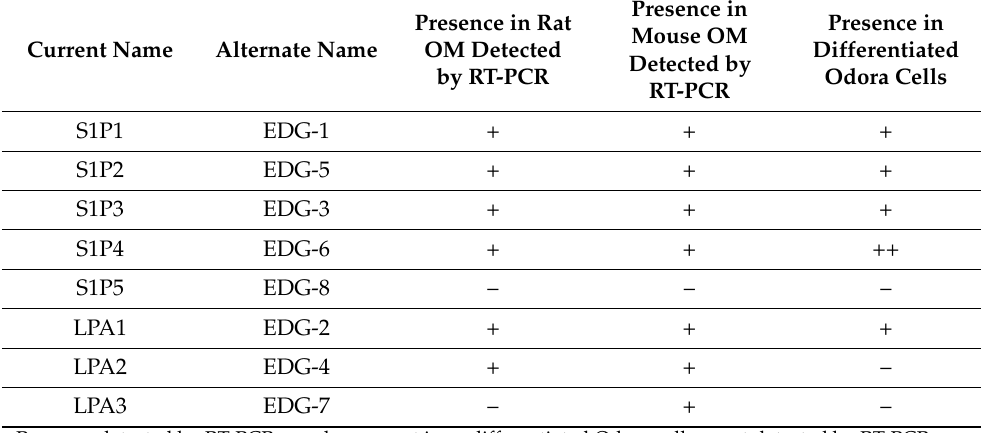
Table 1. S1P and LPA receptors detected in rat and mouse olfactory mucosa (OM) by